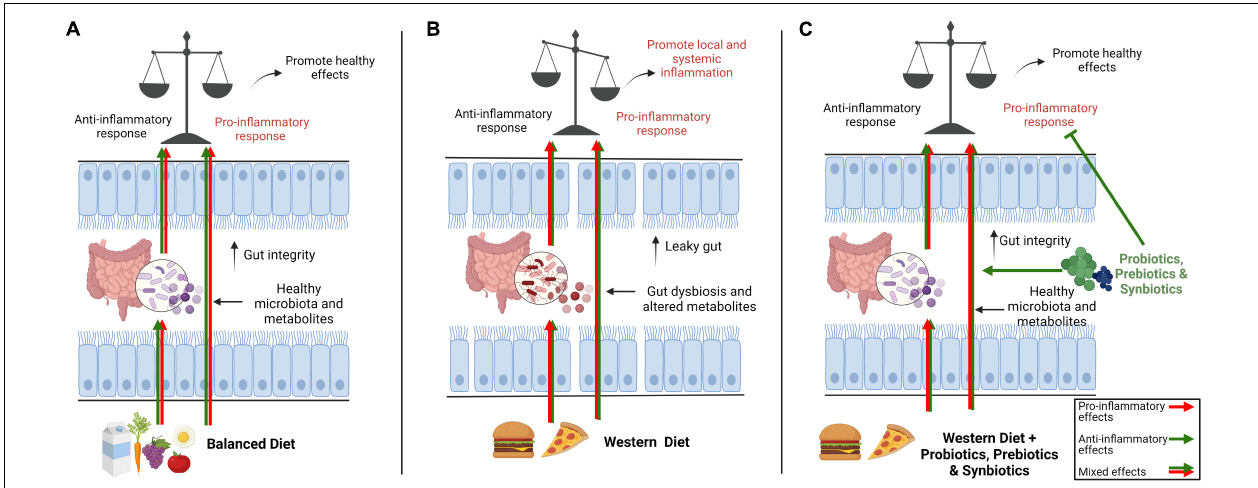
FIGURE 4 | Overview of the impact of a balance diet versus western diet on gut microbiota and immune system and potential roles of interventions such as prebiotics, probiotics and synbiotics on microbiota-immune axis. In general, a balance diet modulates gut immune system directly or indirectly through gut microbiota with a mix of pro- and anti-inflammatory signals so that the immune system stays alert to keep its defenses but also remain tolerant to unnecessary signals to avoid needless inflammation (A) . The pro-inflammatory components in western diet including low-quality fats (trans fatty acids and refined oils), refined carbohydrates (sugar and refined grains), unhealthy additives, processed red meat and salts directly modulate the immune system or negatively impact gut microbiota, causing dysbiosis and changes in metabolites leading to a leaky gut. Consequently, the gut immune homeostasis is shifted toward local or systemic chronic inflammation (B) . Different interventions like prebiotics, probiotics and synbiotics can potentially amend dysbiosis and gut barrier integrity by promoting healthy gut microbiota and conferring their anti-inflammatory effects on immune system to restore gut immune homeostasis (C) .